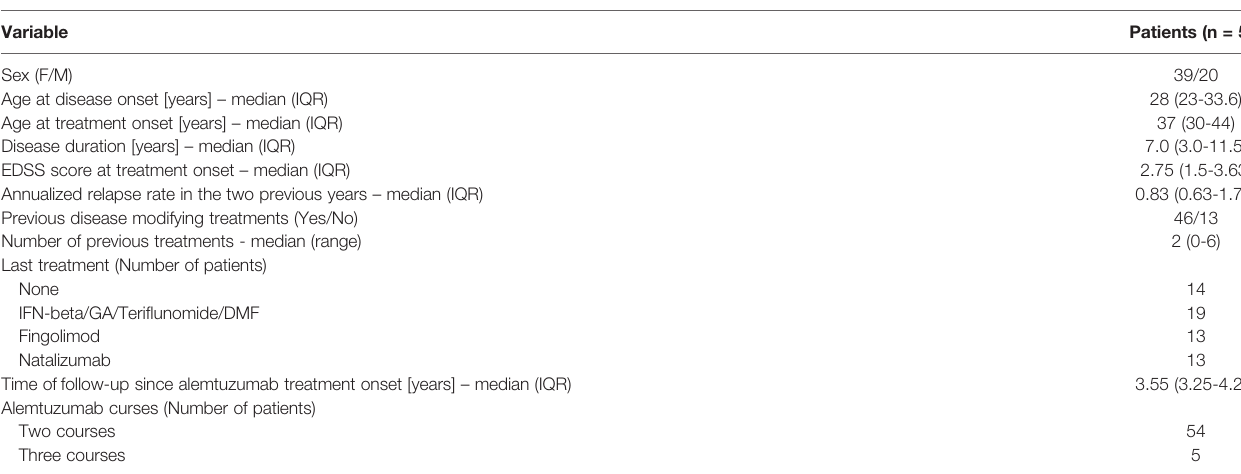
TABLE 1 | Clinical and demographic features of